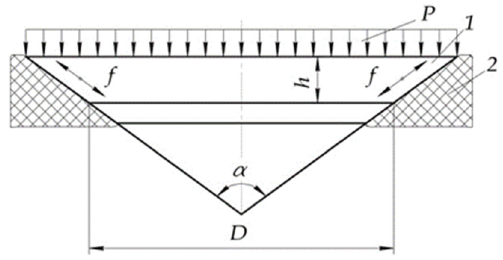
Figure 1. Porthole computational model: P— hydrostatic pressure; f— sliding with friction; 1—translucent element; 2—porthole body.